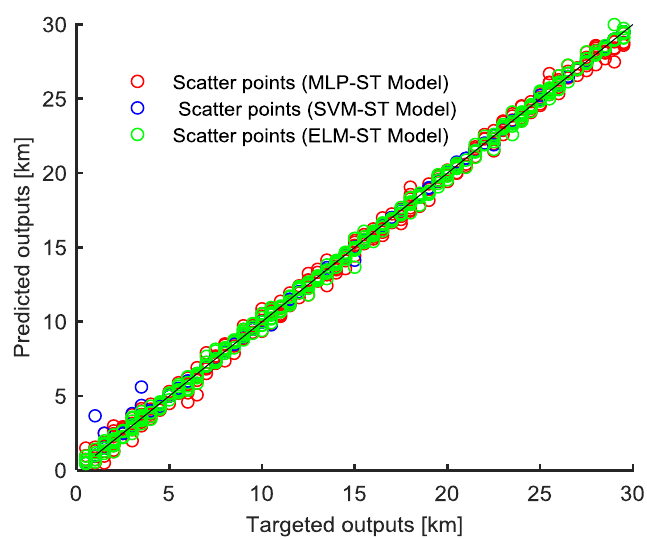
Figure 7. Scatter plot of the targeted and the ST based CF-PSO optimized MLT predicted outputs for the test dataset of AG fault.